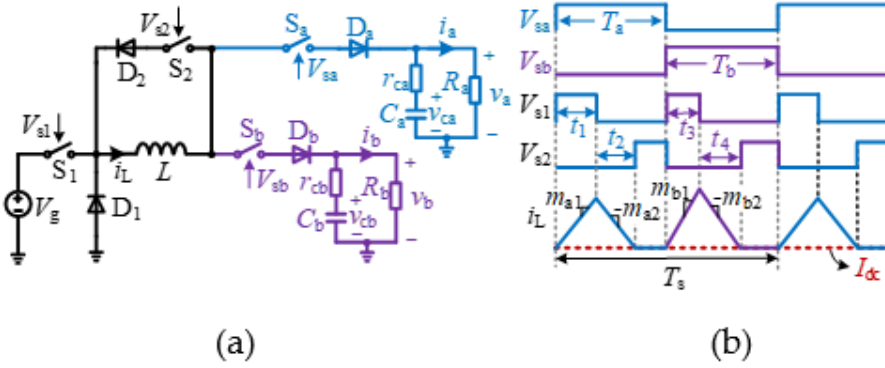
Figure 1. Power stage ( a ) and operation waveforms ( b ) of PCCM SIDO buck